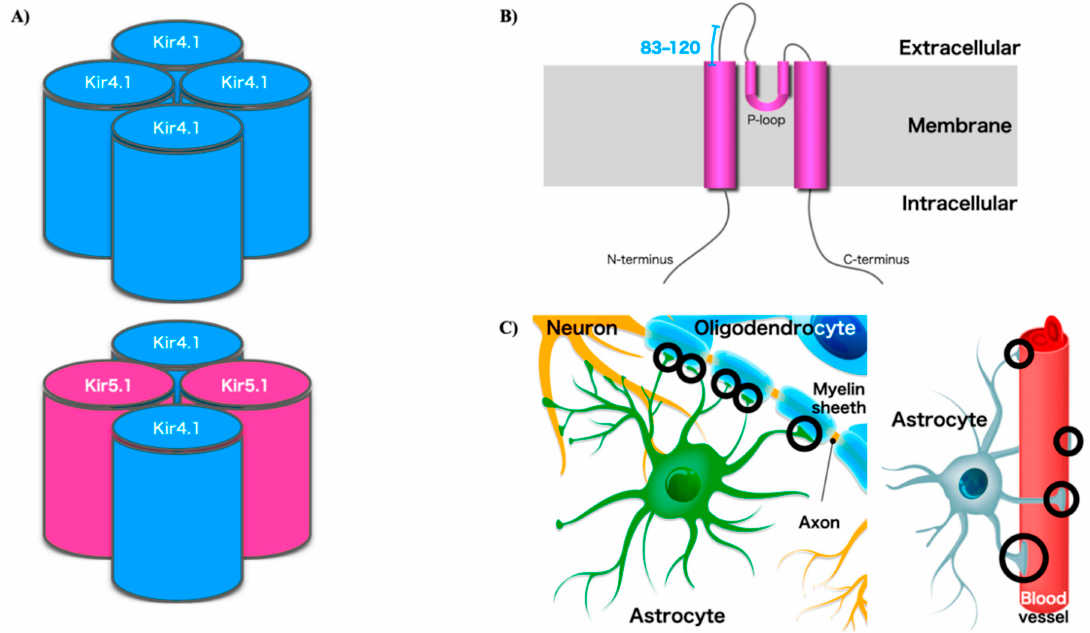
Figure 1. ( A ) KIR4.1 is expressed in vivo as a homotetramer (four units of KIR4.1) or a heterotetramer withKIR5.1(twounitsofKIR4.1andKIR5.1). ( B )Theproteincontainstwoextracellulardomainsandtwo transmembrane regions. Structural diagrams of KIR4.1. The region near the P-loop (residues 83–120) is the putative site recognized by the Kir4.1 autoantibodies (Srivastava et al. 2012 [14]). ( C ) Kir4.1 channels localize on astrocytes at perisynaptic or perivascular processes, or myelin membranes, and control spatial K + bu ff ering (circled). KIR4.1 channels are essential for potassium homeostasis in the brain by maintaining the ionic and osmotic environment in the extracellular